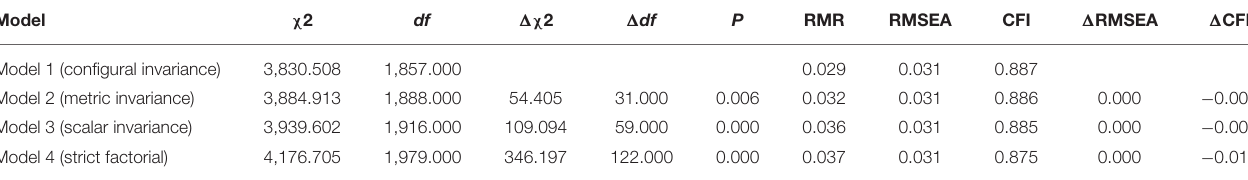
TABLE 8 | Multigroup CFA fit indices for the preschool learning skills scale across grade ( n = 1,137). Model Model 1 (configural